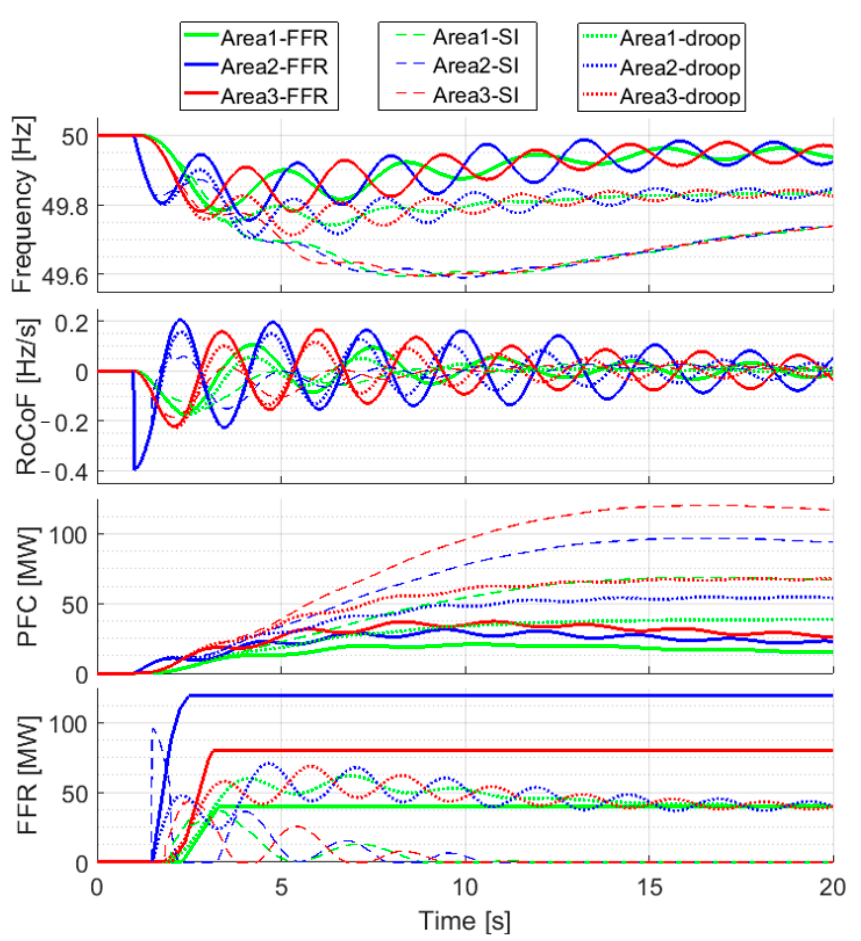
Figure 15. Three-area test system response in the case of a disturbance in Area2—Different line lengths—Case 1.3.